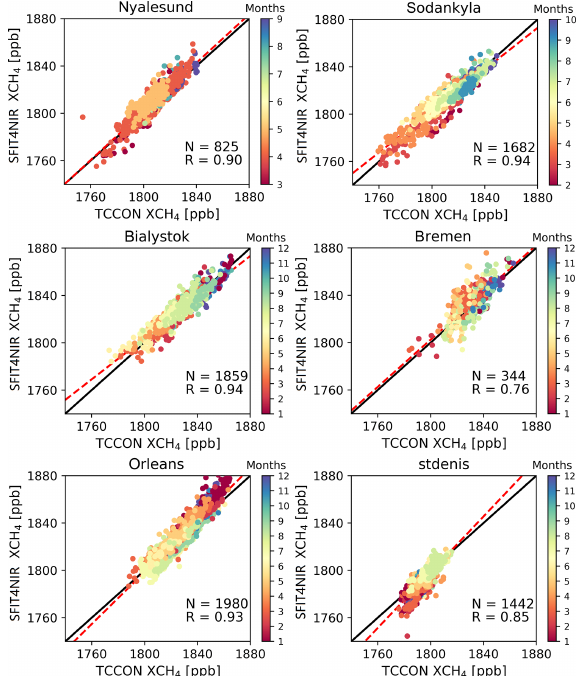
Figure 6. The scatter plots between SFIT4NIR and TCCON X CH hourly retrievals at the six TCCON sites. The dots are coloured with the measurement months. In each panel, the black line is the one- to-one line and the dashed red line is the linear fitting. N is the measurement number and R is the correlation